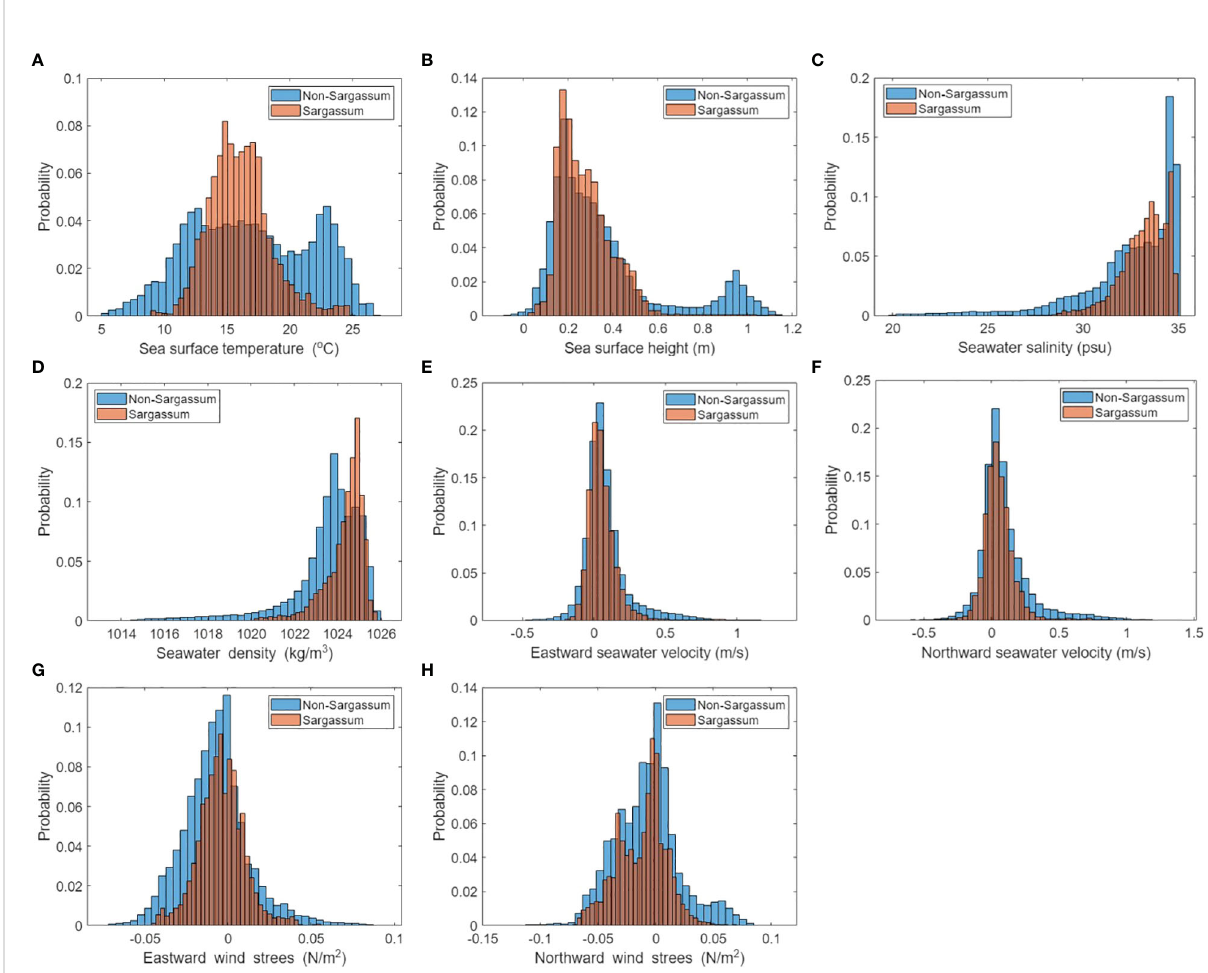
FIGURE 3 The histograms of Sargassum and non- Sargassum pixel groups corresponding to (A) SST, (B) SSH, (C) SS, (D) rho , (E) uo , (F) vo , (G) wsu , and (H) wsv . The pixels for each group extracted from GOCI images as ground truth data are shown in Table